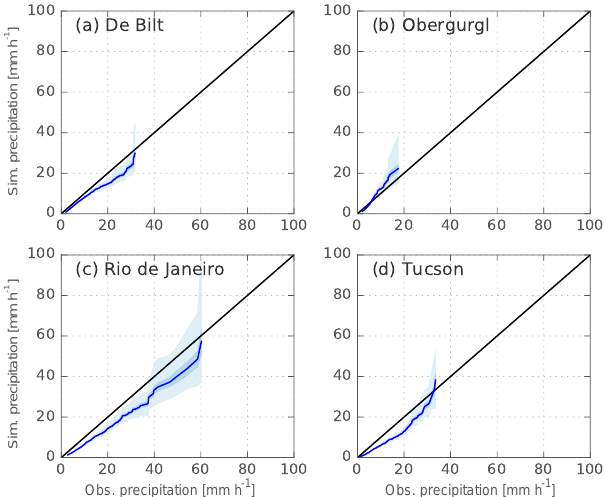
Figure 13. Modelled (blue) vs. observed (black) precipitation in- tensities for the 1% highest intensities derived using a split-sample test for the cascade model (P2). For all panels the shaded areas refer to the standard deviation (dark blue) and range of values (light blue) computed for 100 realisations, respectively.